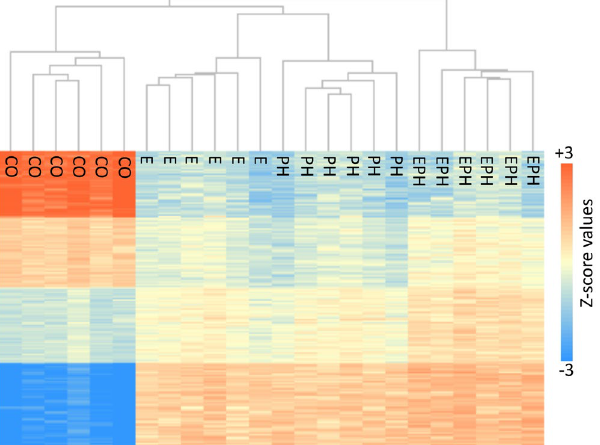
Figure 3. Heatmap, showing the standardized methylation ratios of the DM CpG dinucleotides, identified between the control group ( CO ) with individuals in the stressed embryonic ( E ), post-hatch ( PH ) and embryonic and post-hatch ( EPH ) groups. Each horizontal line represents a distinct DM